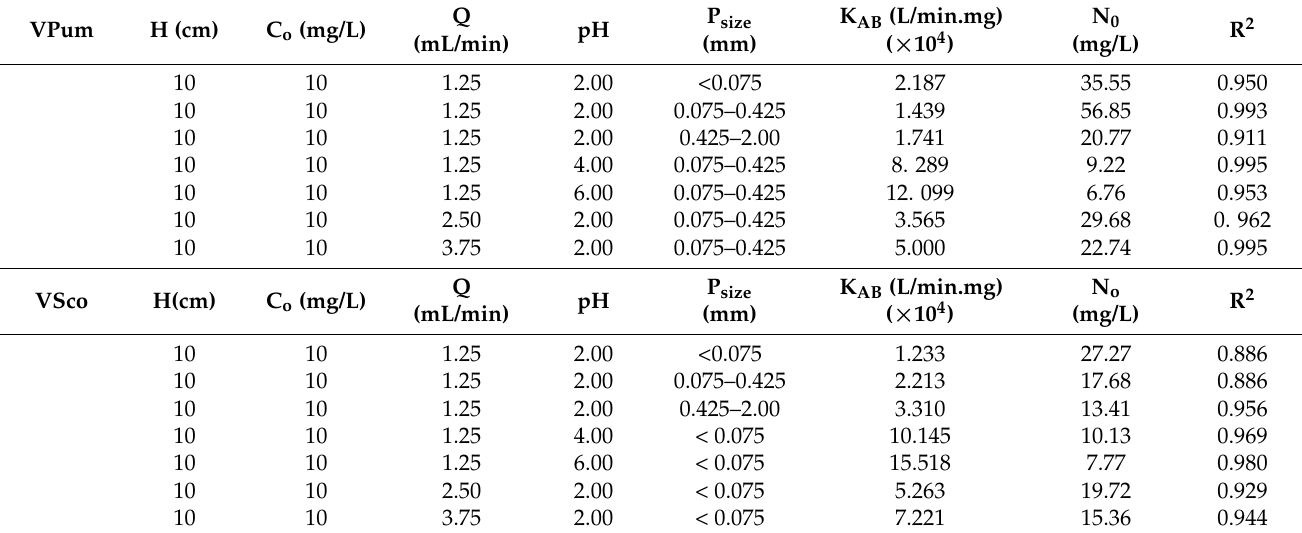
Table 4. Adams–Bohart model parameters for fluoride adsorption onto VPum and